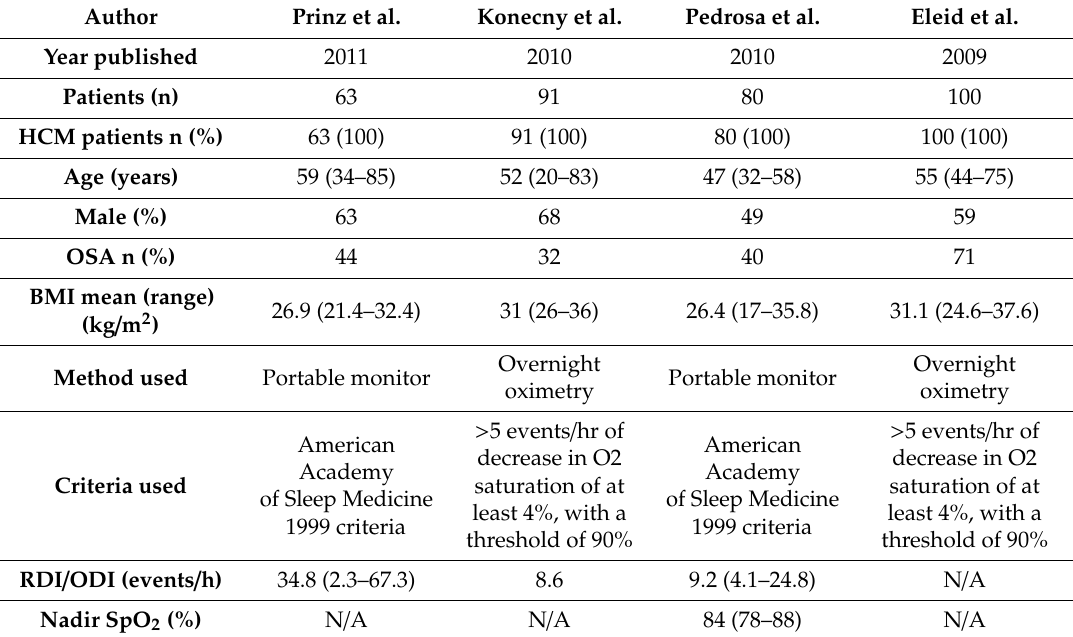
Table 1. Summary of all published studies assessing sleep disordered breathing in patients with hypertrophic cardiomyopathy (HCM). Baseline characteristics are included.